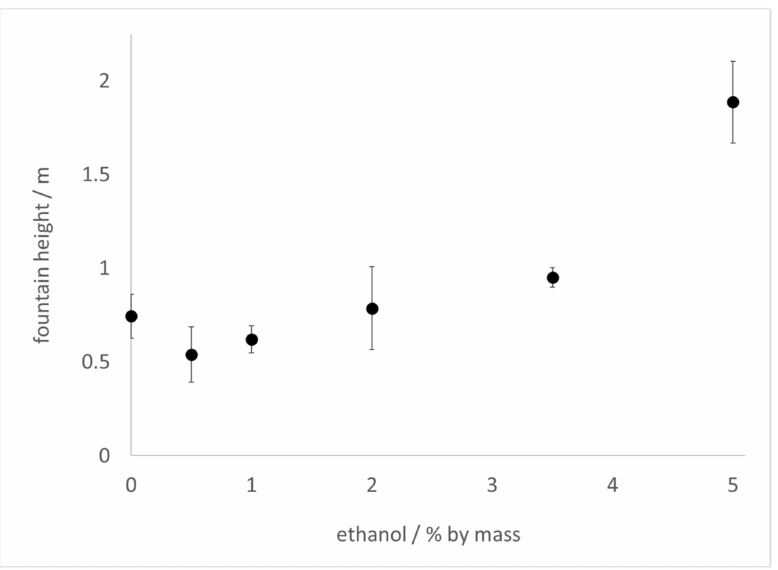
Figure 2. Fountain heights achieved when 2 L of Diet Coke is treated with increasing amounts of ethanol as indicated in the text and then 11 mint Mentos are added at 20–21 ◦ C. Error bars represent one standard